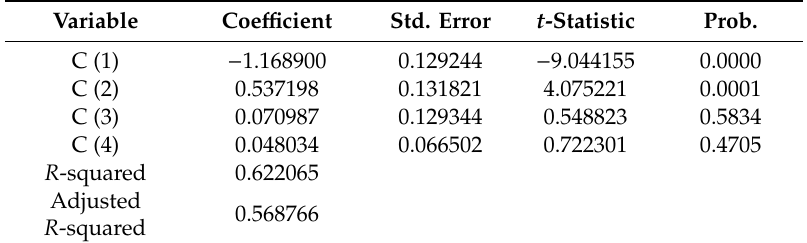
Table 6. Estimation method: least